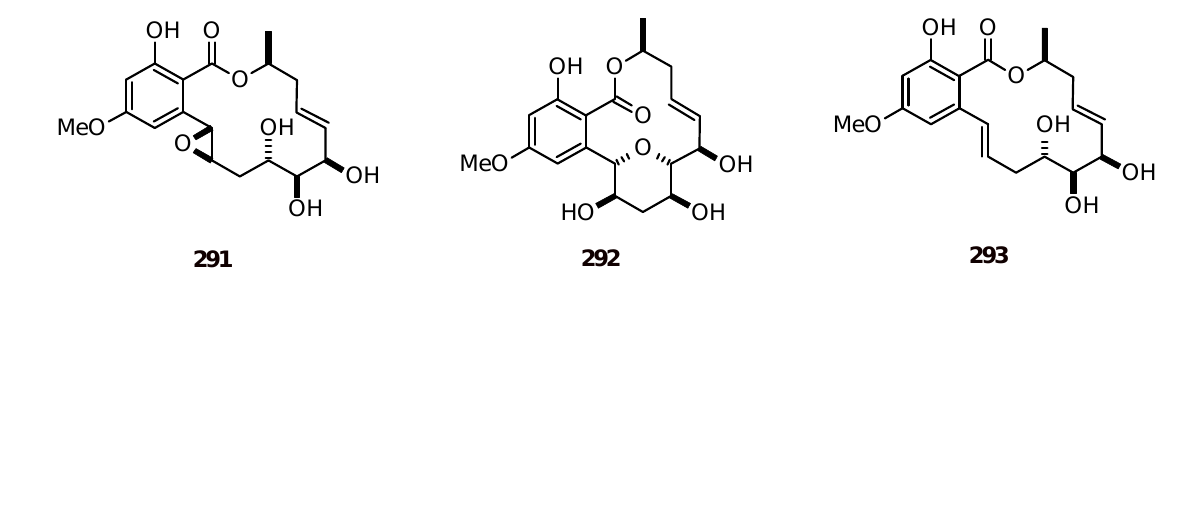
Figure 37. Structures of  -resorcylic acid lactones 291 - 297